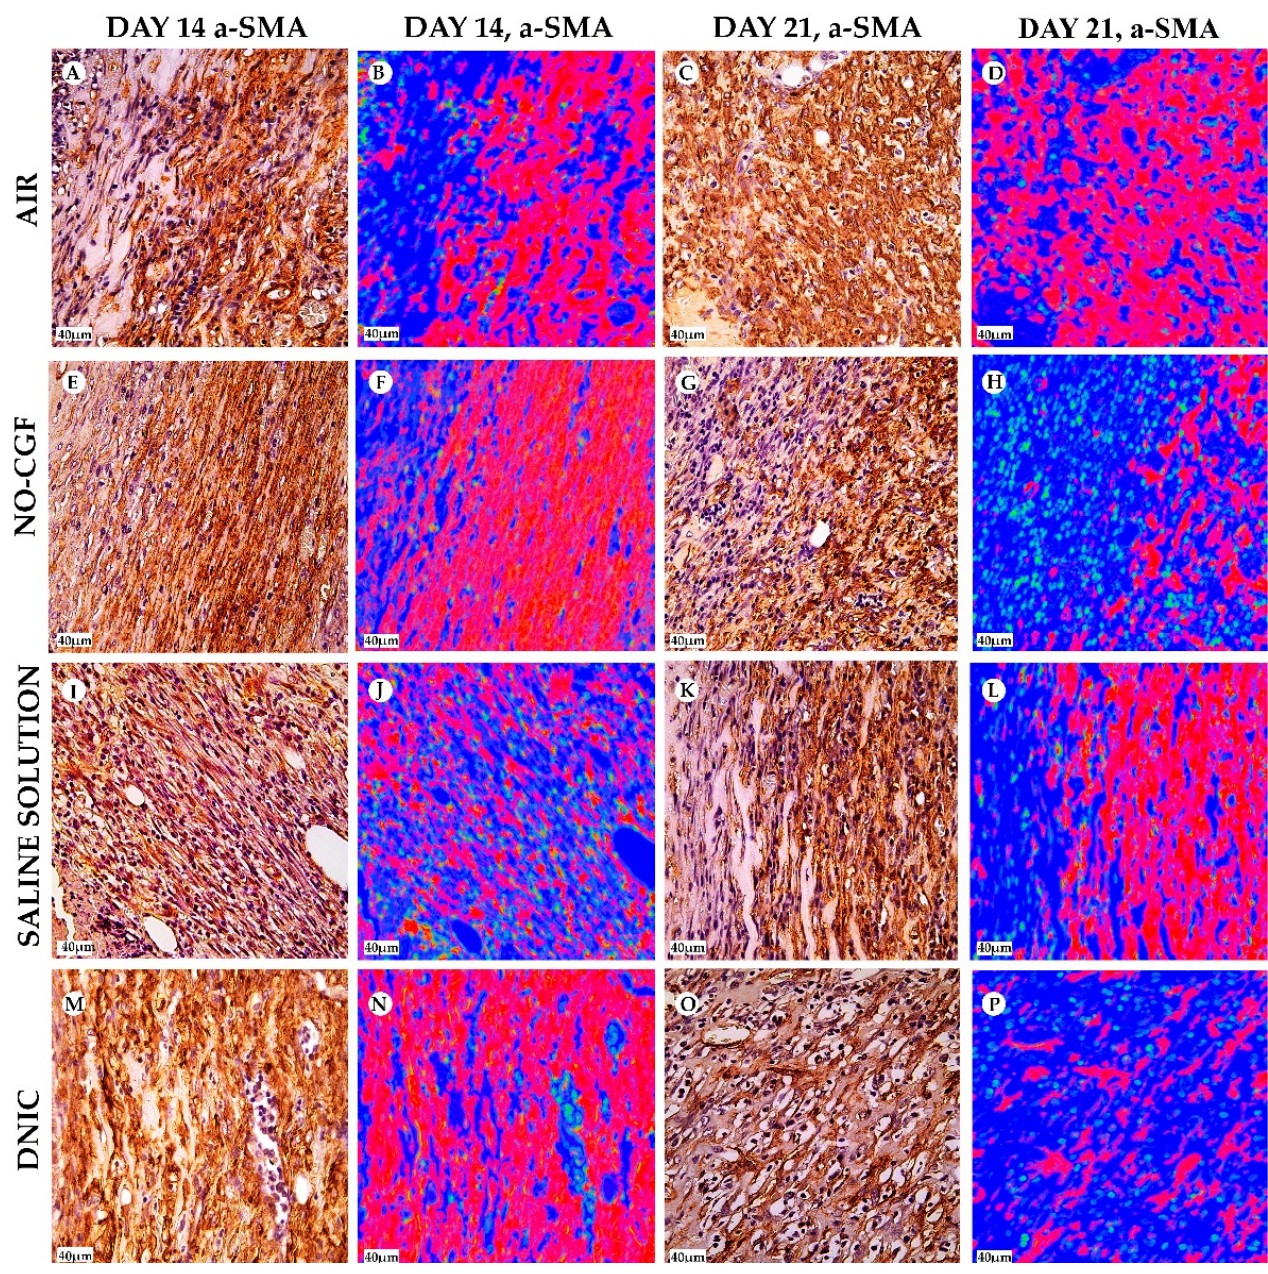
Figure 13. α -SMA expression and α -SMA-positive cells distribution in the study groups on days 14 ( A , B , E , F , I , J , M , N ) and 21 ( C , D , G , H , K , L , O , P ), magnification × 400. Red— α -SMA-positive cells, green— α -SMA-negative cells, blue—background. ( A ) α -SMA expression in deep part of wound, ( B ) thick layer of red-stained cells, ( C ) diffuse α -SMA expression, ( D ) monolayer of red-stained cells, ( E ) α -SMA-positive spindle-shaped cells, ( F ) dense layer of red-stained cells, ( G ) SMA-positive cells in deep part of wound, ( H ) low content of red-stained cells, ( I ) α -SMA-positive cells in granulation tissue, ( J ) parallel orientated red-stained cells, ( K ) intensive α -SMA expression, ( L ) a layer of red-stained cells in deep part of wound, ( M ) numerous α -SMA-positive cells along collagen fibers, ( N ) dense red-stained layer, ( O ) α -SMA expression in endothelial cells and ( P ) singular red-stained cells.